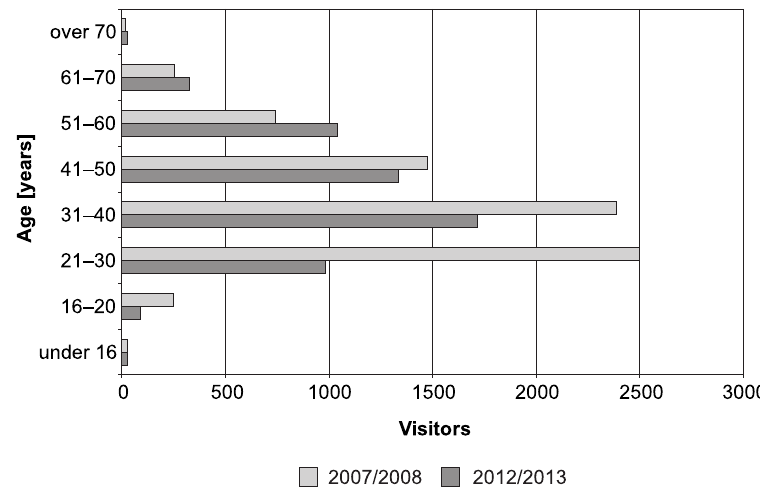
Fig. 9. Visitors to the Aconcagua massif according to their age in season 2007/2008 and